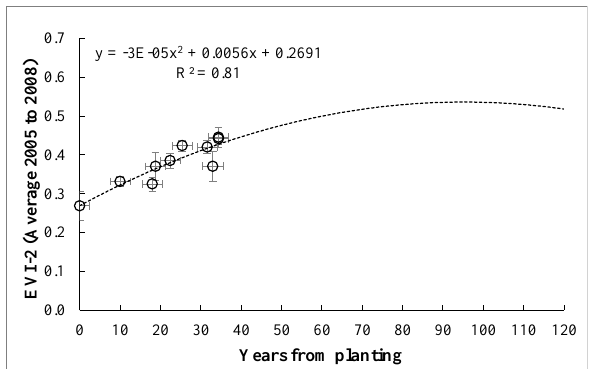
Figure 2. Relationship between the average EVI-2 and age of red pine forest for each sampling